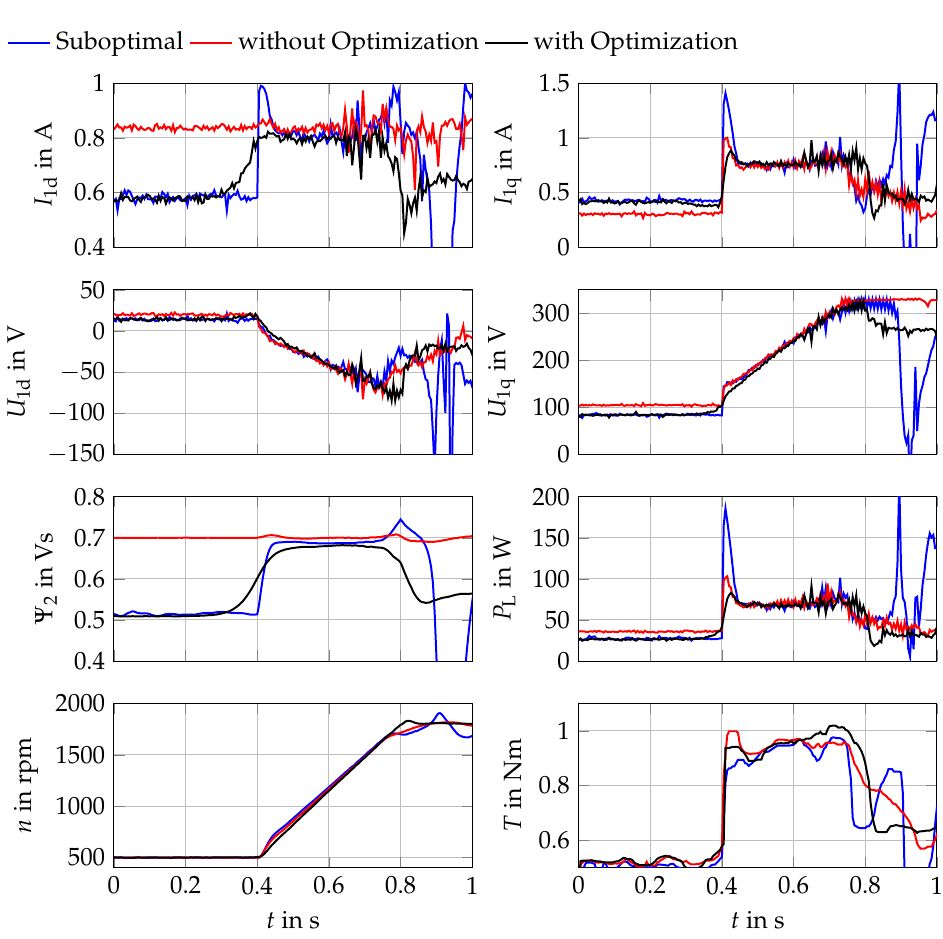
Figure 15. Measurement results for the optimization procedure.